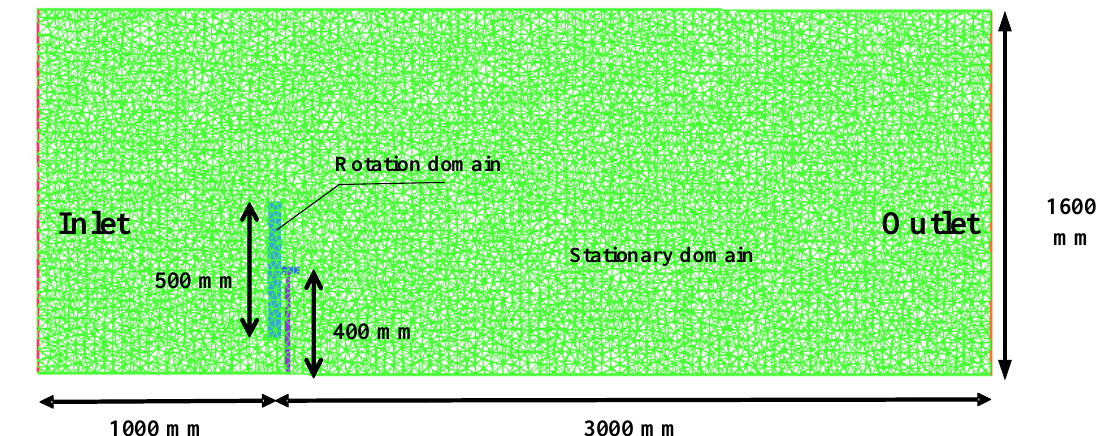
Figure 3. Grid of the computational stationary domain.